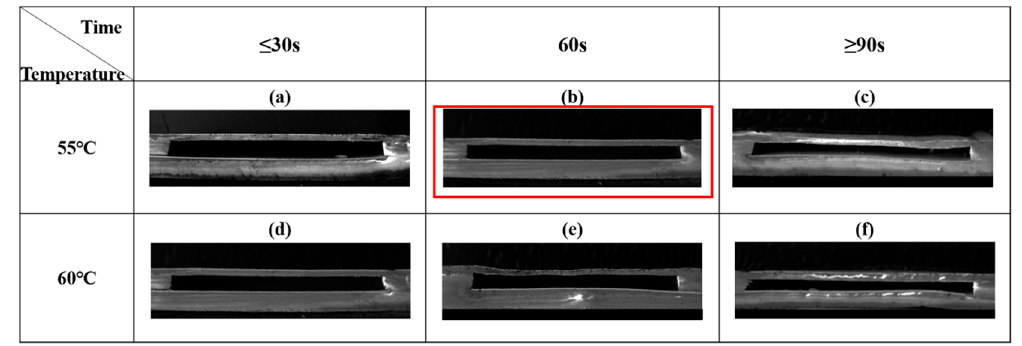
Figure 5. SEM images of the cross-section of cavities under different laminating conditions: ( a ) (cid:1846) = 55 (cid:1320), (cid:1872) (cid:3409) 30 s ; ( b ) (cid:1846) = 55 (cid:1320), (cid:1872) = 60 s ; ( c ) (cid:1846) = 55 (cid:1320), (cid:1872) (cid:3410) 90 s ; ( d ) (cid:1846) = 60 (cid:1320),(cid:1872) (cid:3409) 30 s ; ( e ) (cid:1846) = 60 (cid:1320), (cid:1872) = 60 s ; ( f ) (cid:1846) = 60 (cid:1320),(cid:1872) (cid:3410) 90 s